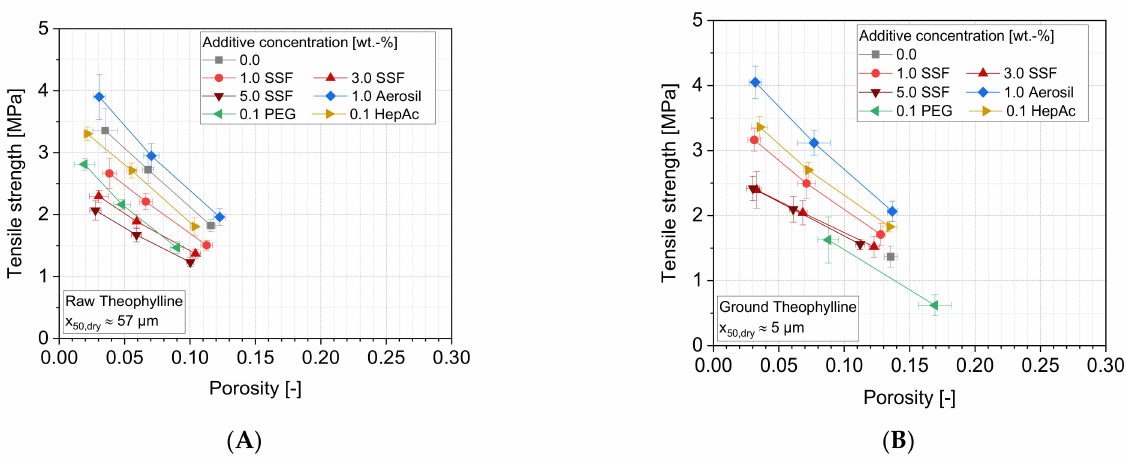
Figure 15. Tensile strength as a function of the tablet porosity for different additives: ( A ) raw theophylline and ( B ) ground theophylline. Due to capping, some tablets without additive and PEG cannot be evaluated, n =